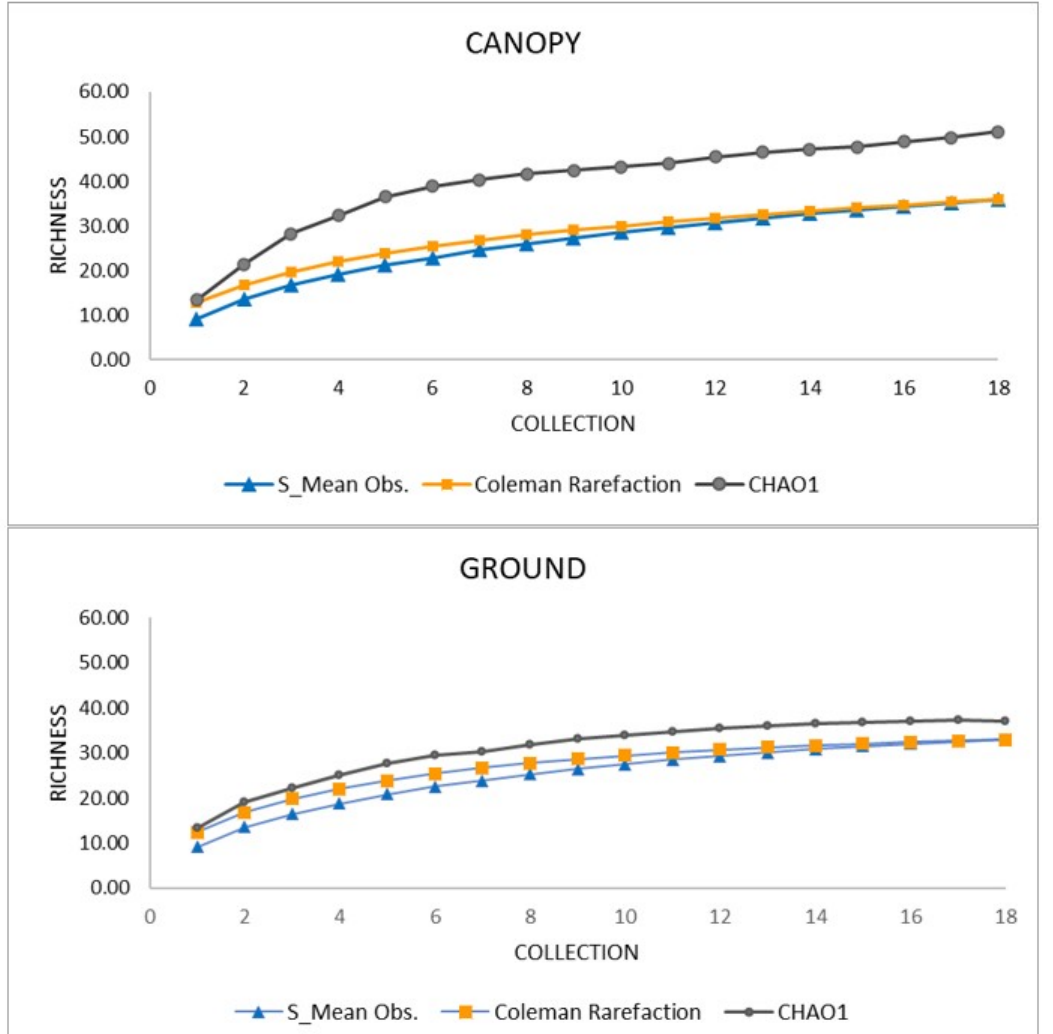
Figure 2. Species accumulation curves of females collected from October 2019 to March 2020, in the canopy and ground strata. Guarulhos, SP, Brazil.